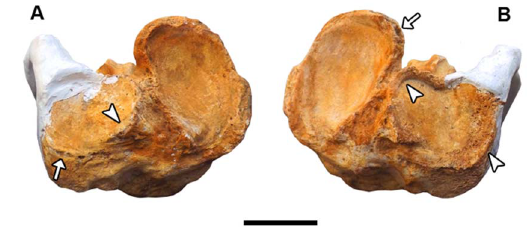
Figure 5. Patellae of Glyptotherium. (A) Right patella MCC 464-V in caudal view; (B) left patella MCC 473-V in caudal view; (C) Cranio-caudal radiography of the left patella. The white arrows indicate osteophytes, and the red circle indicates calcium deposition. Scale bar = 5 cm.